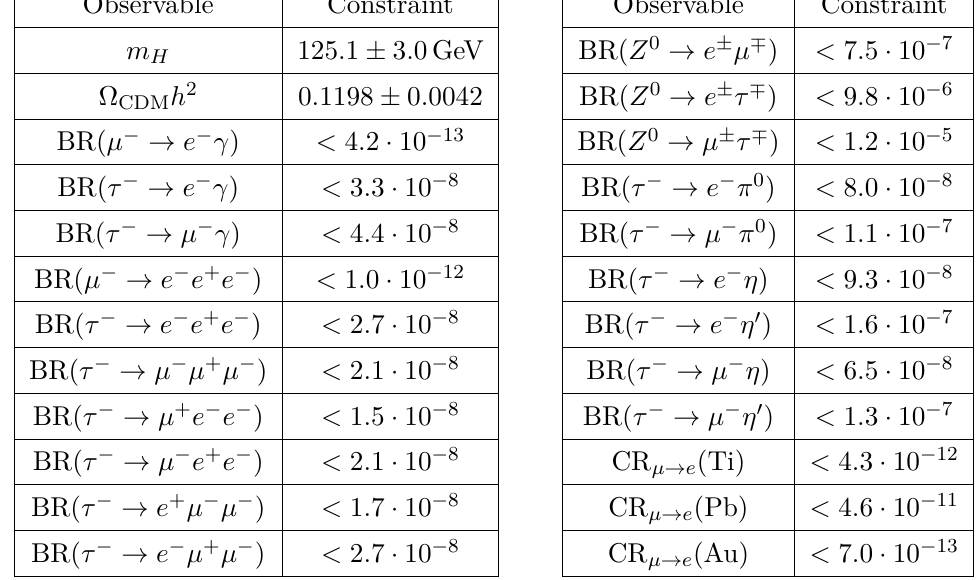
Table 4 . Constraints stemming from Higgs mass measurement [61], dark matter relic density [62], as well as flavour and low-energy precision data [58]. In our setup, intervals given at the 1 σ confidence level are implemented using a Gaussian function, while upper limits are given at the 90% confidence level and are implemented with a single-sided Gaussian allowing for a 10%